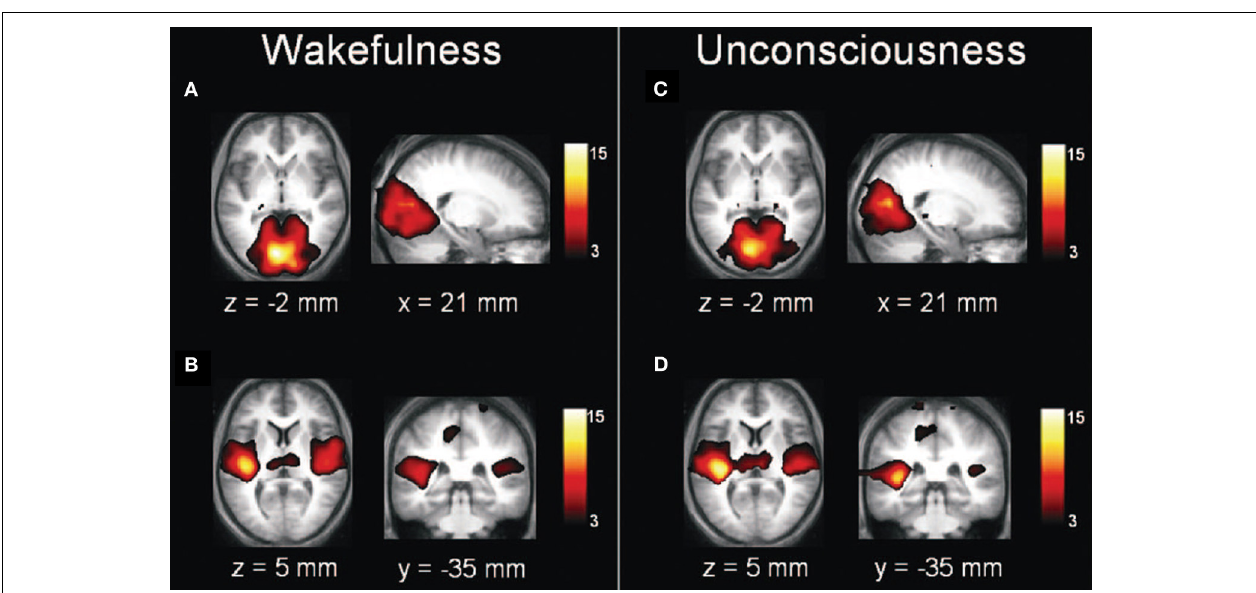
FIGURE 2 | Anesthetic-induced unconsciousness is not correlated with inactivation of primary sensory cortex. Transverse and sagittal sections of primary visual (A,C) and auditory (B,D) cortices during wakefulness (A,B) and